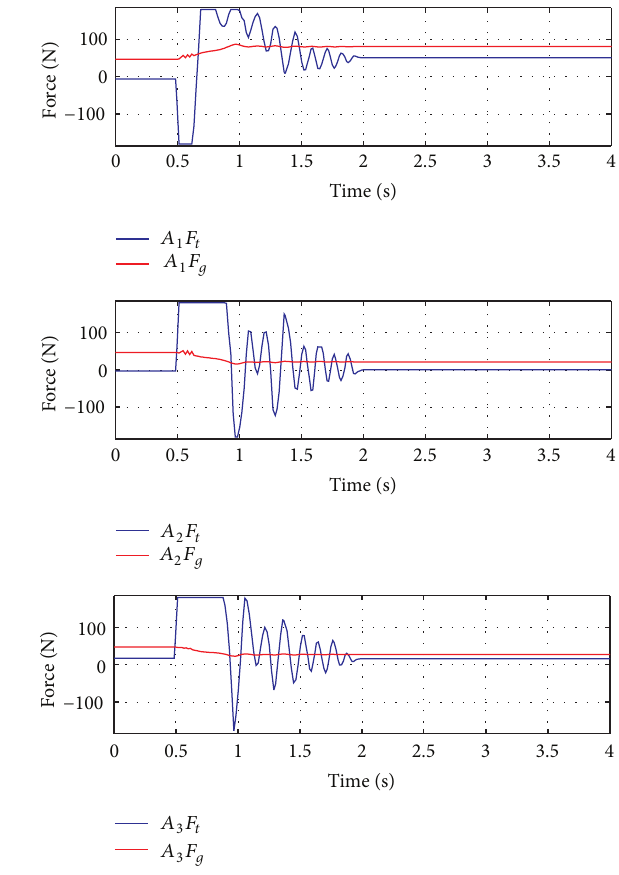
Figure 15: Task-space PID with gravity compensation: 𝐹 𝑡 total force provided by the motors, 𝐹 𝑔 gravity